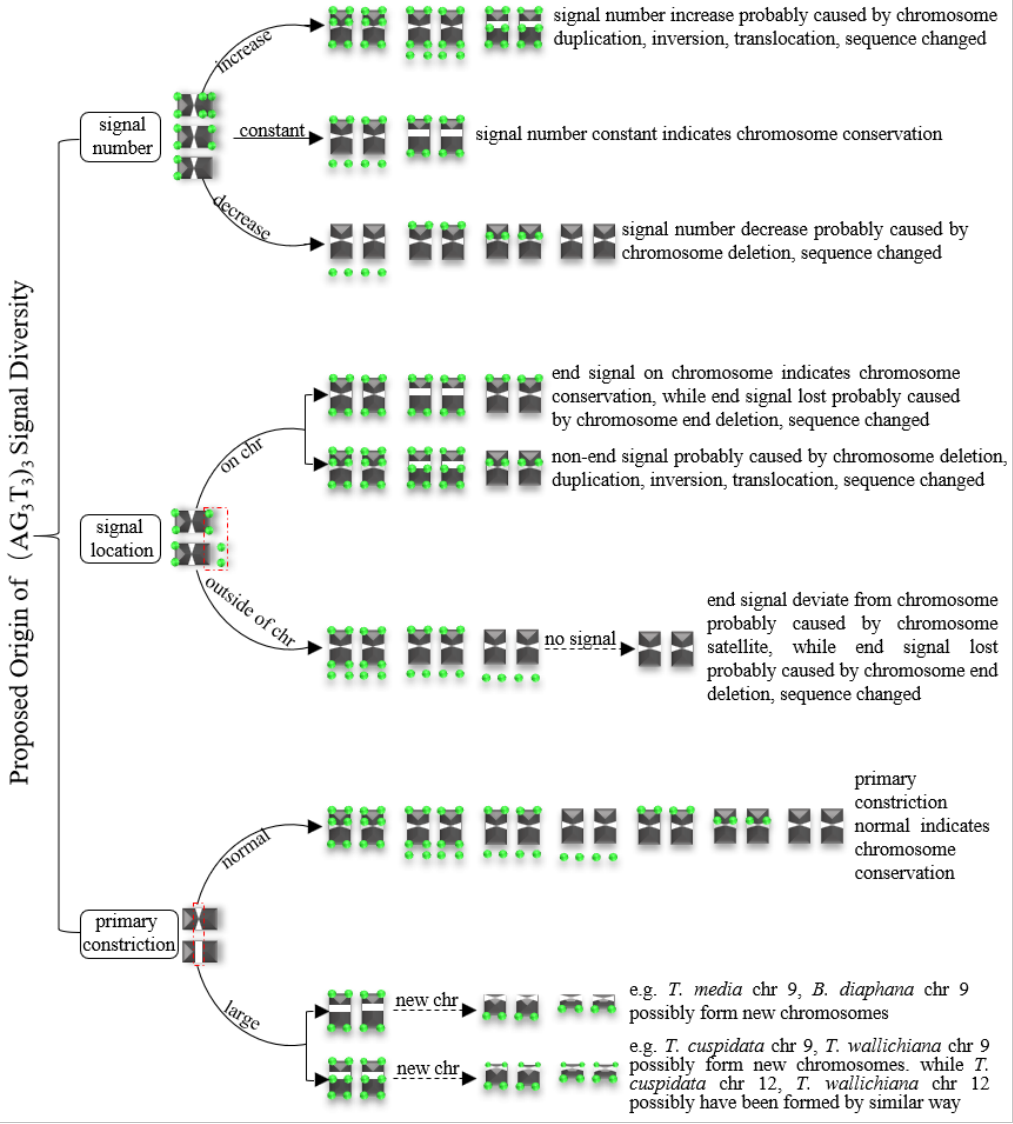
Figure 11. Proposed origin of (AG 3 T 3 ) 3 signal diversity. The variations in signal number and signal location were likely caused by chromosome deletion, duplication, inversion, translocation, as sequence changes, as well as chromosome satellites, while primary constriction became large due to chromosome breakage and the formation of new